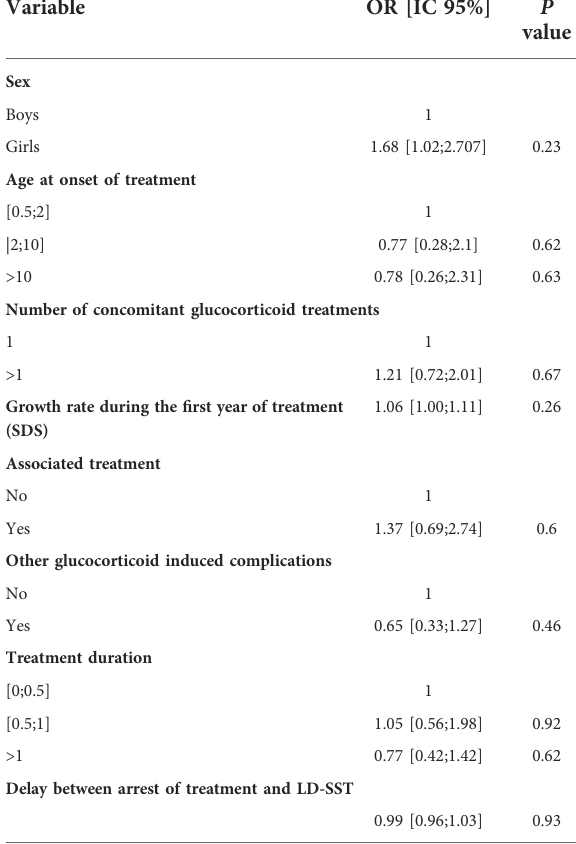
TABLE 3 Analyses of potential predictive factors for HPA axis